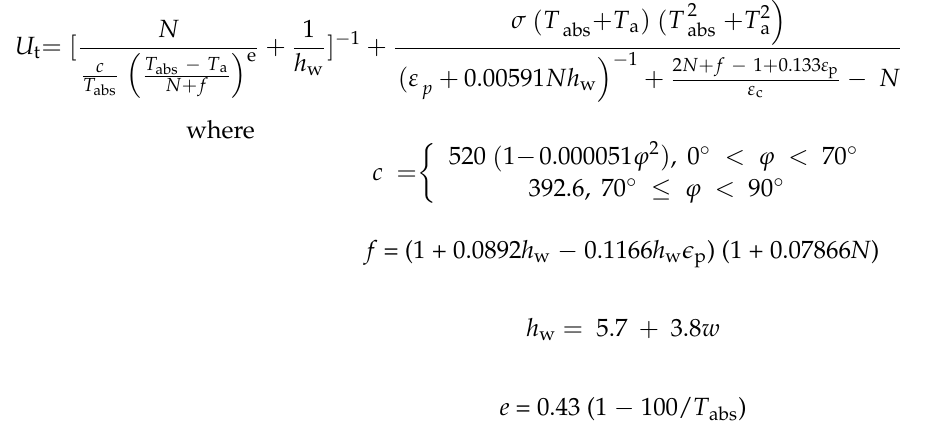
Figure 7. Thermal network diagram of VTBC solar collector in terms of conduction, convection, and radiation thermal